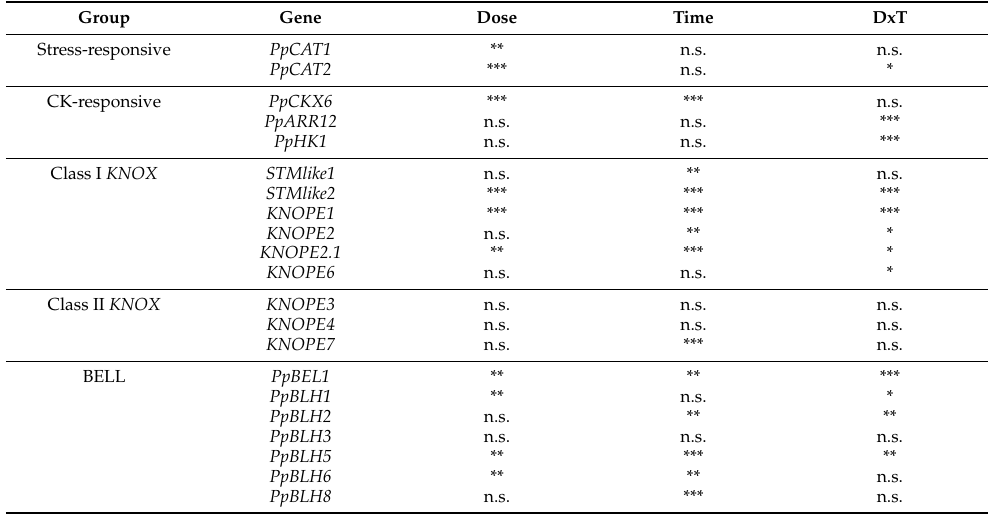
Table 3. Significance overview from ANOVA results relative to the gene expression levels in GF677 clones as affected by cytokinin dosage, time, and